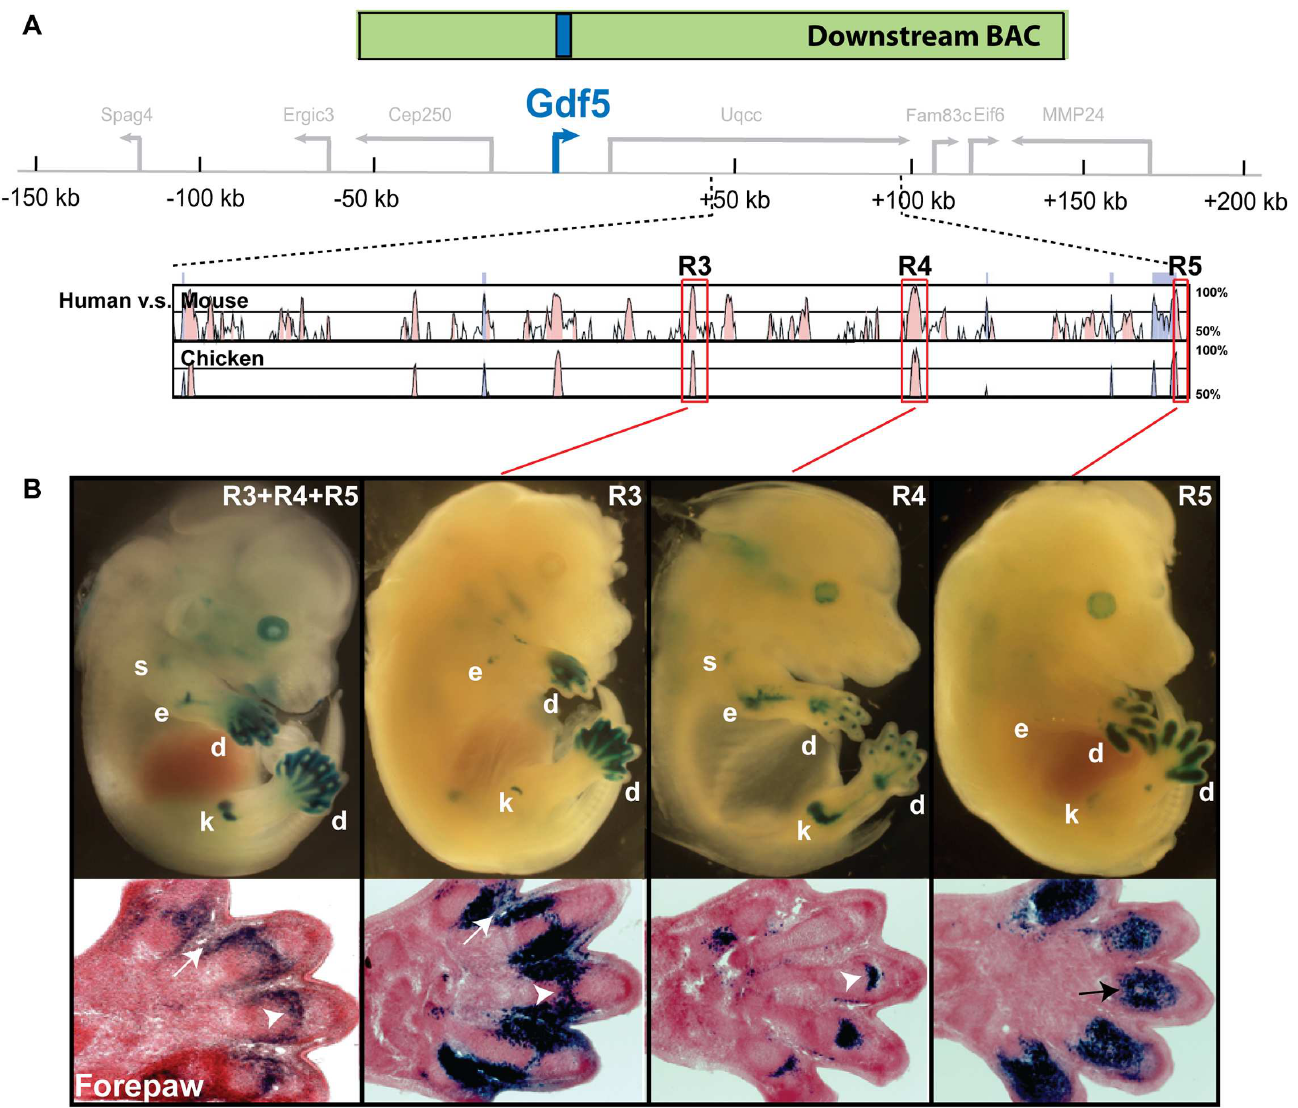
Fig 4. A cluster of three downstream regulatory enhancers interact to control gene expression in distinct distal limb tissues. ( A ) Three evolutionarily conservedelements(red boxes) within the DownstreamBAC (green)regionwere identifiedvia a comparisonof mouse, chicken, and human sequences. Pink peaks represent conservednon-coding sequenceshowingat least 70% nucleotideidentity over a 300 bp window,while blue peaks reflect conservation in codingsequence.( B ) Transgenic embryos collectedat E14.5 from constructs containing either all three conservednon- coding elementsas a concatenate(R3+R4+R5) (left) or individual regulatoryelements(R3, R4, or R5 as indicated). Panels beloweach embryo are histological sectionsof the forepawdigital domains.When combined,all three elements(R3+R4+R5) drive weak expressionin proximallimb joints such as the shoulder (s) and strong expressionin the distal limb joints, such as the elbow (e), knee (k), and digits (d), along with the interdigitalspace (white arrow). R3 by itself drives expression in distal joints but also strongly in the interdigitalspace (white arrow) and interphalangealjoint (white arrowhead);R4 drives expressionin distal limb joints including the interphalangeal joint (white arrowhead);and R5 drives expressionweaklyin distal limb joints, yet strongly in the phalangealmesenchyme of the digits (black arrow).